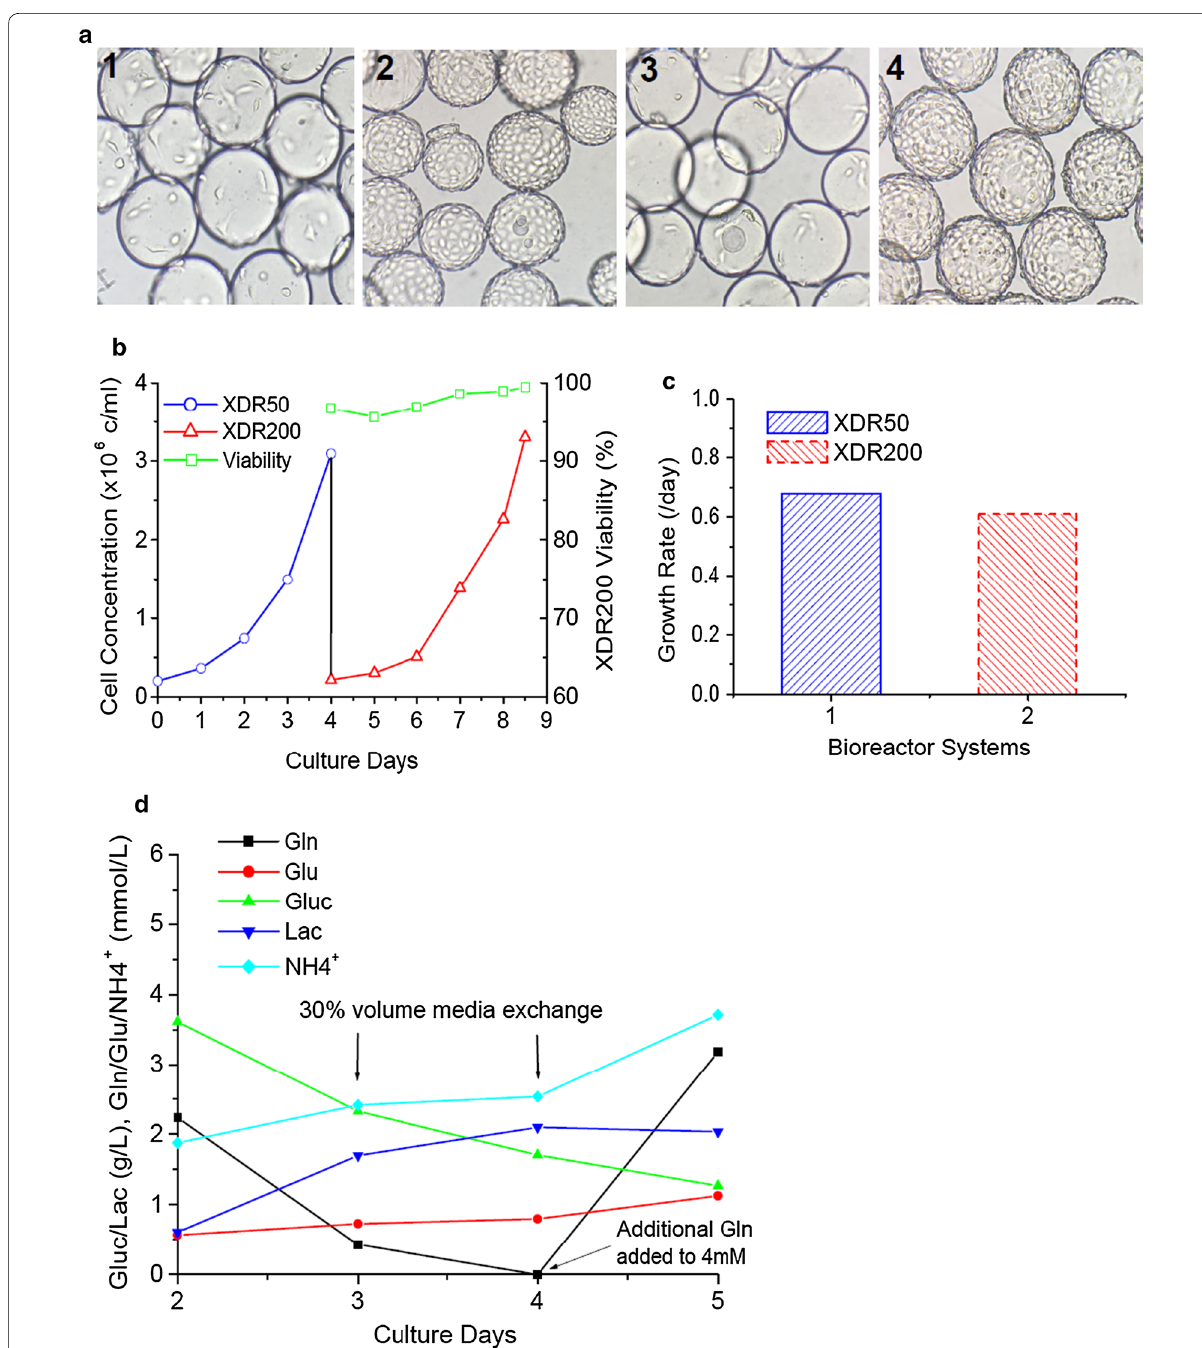
Fig. 7 Vero cells growth in XDR-50 and XDR-200 bioreactors. a The pictures of Vero cell growth in XDR-50 on day 1 (1) and day 4 (2), and in XDR-200 on day 1 (3) and day 4.5 (4). b Cell growth concentration curve in XDR50 and XDR200 bioreactors. c The average specific growth rates in XDR-50 and XDR-200 bioreactors. d Cell metabolite curves in